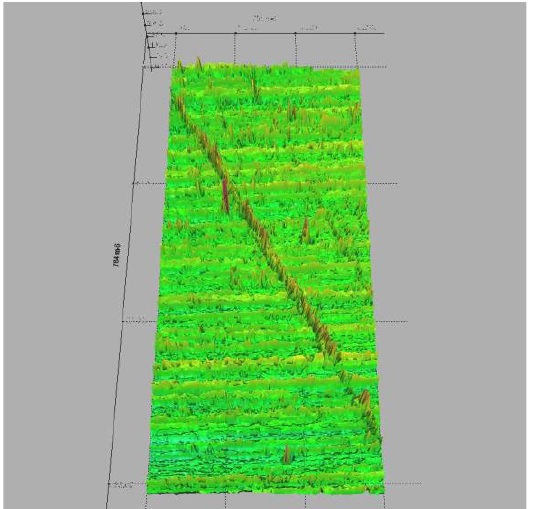
Figure 17. The plastic deformations of the plate along the rolling trajectory obtained by the scanner reflectivity